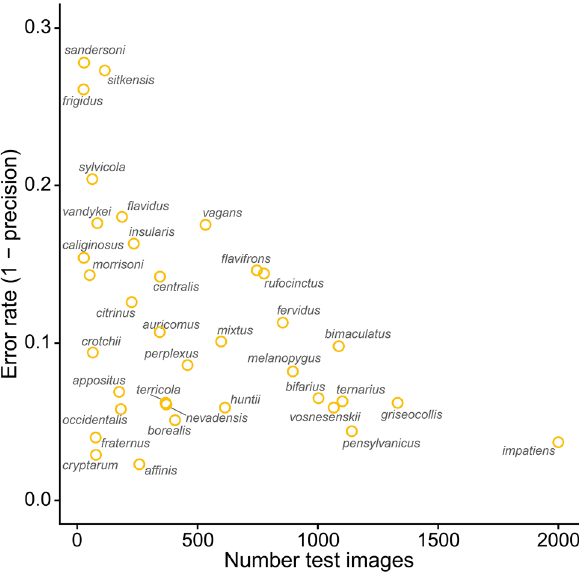
Figure 3. Relationship between error rate and the number of test images.